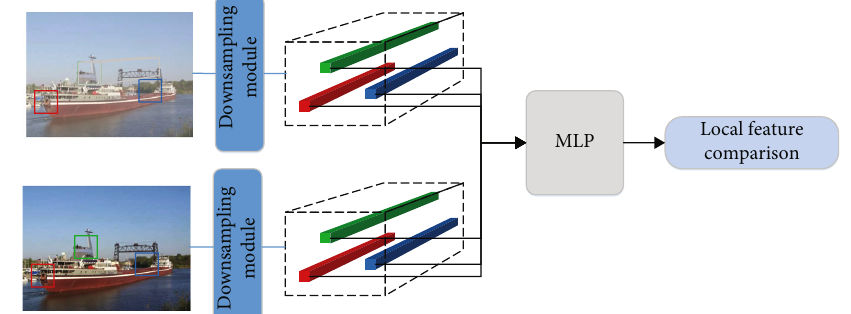
Figure 3: The pipeline of local feature comparison